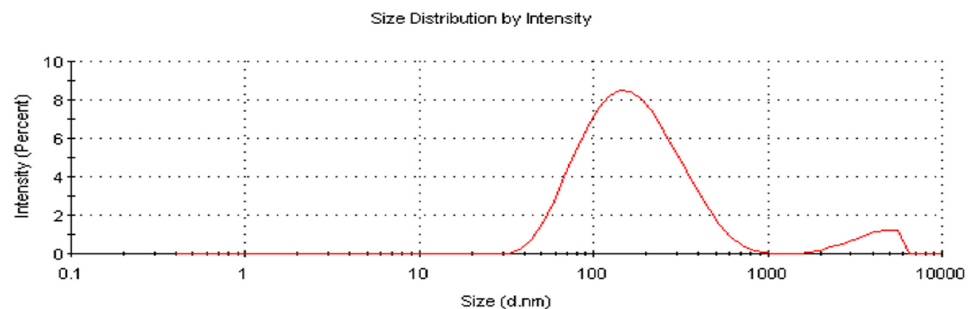
Figure 9. Size distribution pattern of AC-AgNPs.